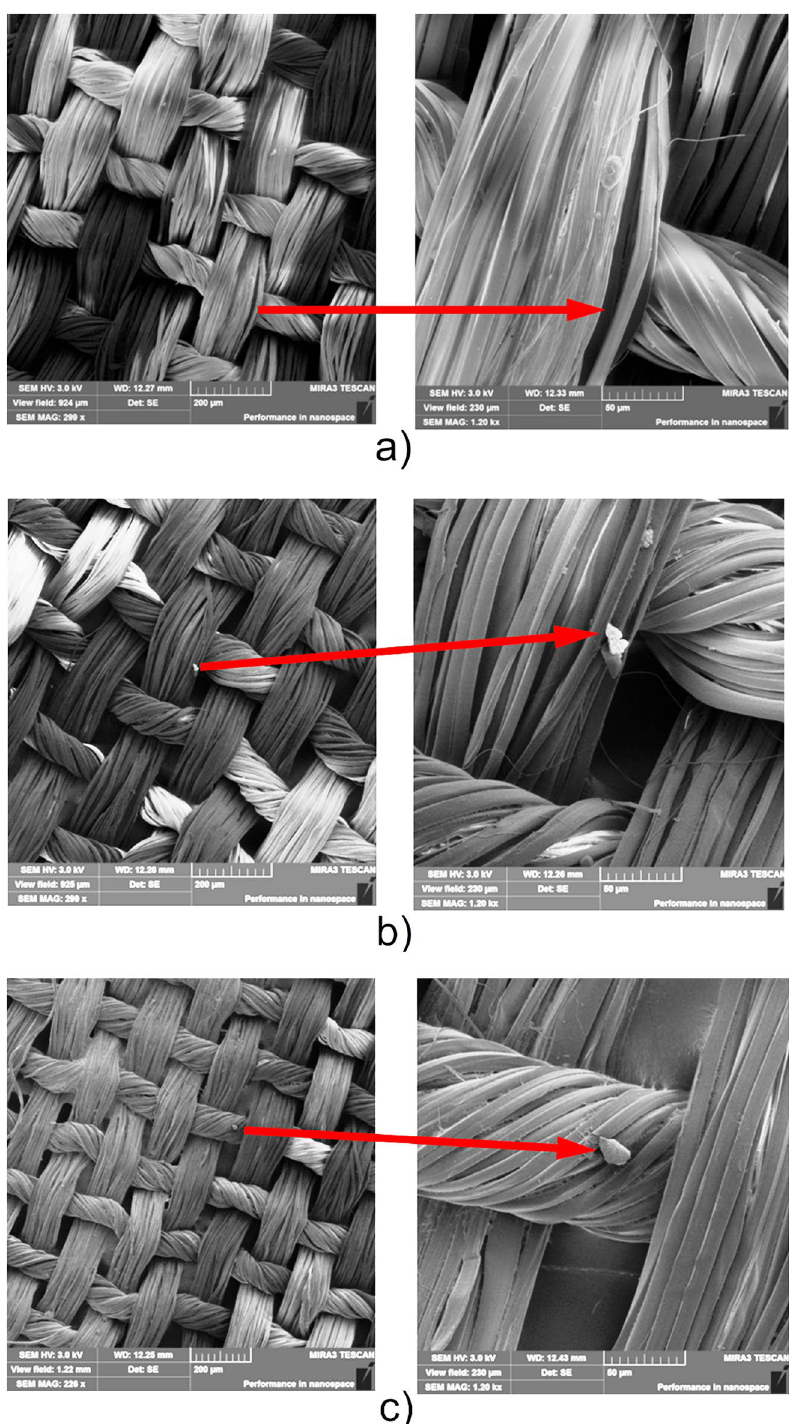
Figure 4. SEM images of glass fabrics: ( a ) initial glass fabric used for PLA-PCB fabrication; ( b ) glass fabric after single recycling; ( c ) glass fabric after triple